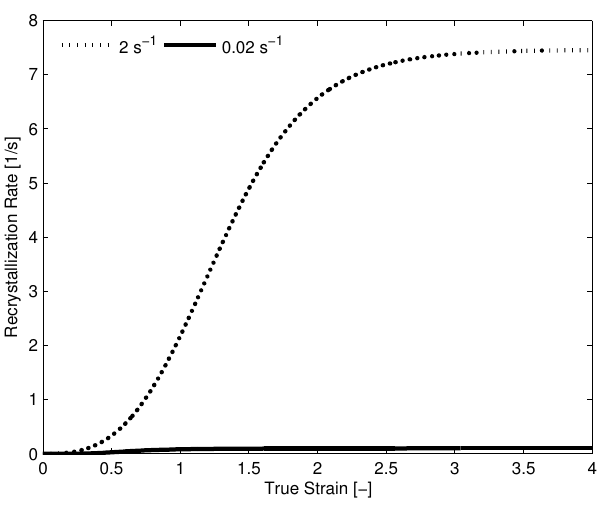
Figure 4. Predicted recrystallization rate HSLA-steel for strain rates 0.02 s − 1 and 2 s − 1 , the maximum recrystallization rate at the higher-strain rate is approximately 74 times that of the lower strain rate. Grain Size